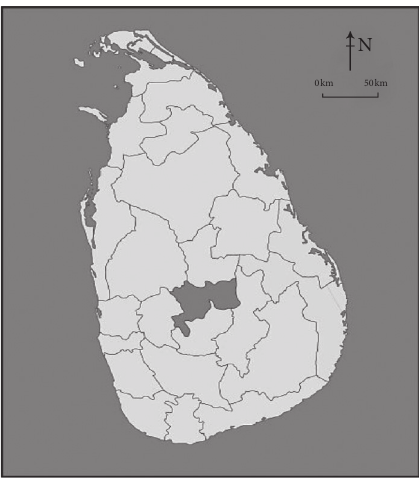
Figure 1: A map of Sri Lanka depicting the study area: Kandy